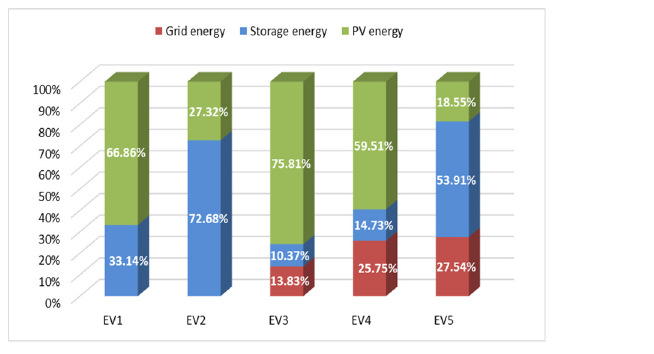
Figure 11. EV energy distribution in ( a ) “Sim w/o opt” and ( b ) “Sim with opt”— case 2.